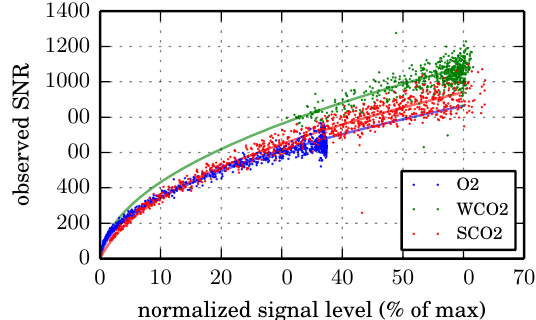
Figure 6. Empirical SNRs of each OCO-2 band derived from Fig. 6. Empirical signal-to-noise ratios of each OCO-2 band de- the standard deviation of spectral residuals from 2000 separate rived from the standard deviation of spectral residuals from 2000 fits. Solid transparent lines represent the expected OCO-2 SNR separate fits. Solid transparent lines represent the expected OCO-2 for a typical detector pixel, which agrees well with the observed SNR for a typical detector pixel, which agrees well with the ob- SNR. For each band (O2A, WCO2, SCO2), the maximum ob- served SNR. For each band (O2A, WCO2, SCO2), the max ob- servable signal is defined as 7 . 0 × 10 20 , 2 . 45 × 10 20 and 1 . 25 × servable signal is defined as 7 . 0 10 20 , 2 . 45 10 20 and 1 . 25 10 20 · · · 10 20 photonss − 1 m − 2 sr − 1 µm − 1 , respectively, where it is taken photons s − 1 m − 2 sr − 1 µ m − 1 , respectively, where it is taken into into account that OCO-2 will only measure one polarization direc- account that OCO-2 will only measure one polarization direction tion (i.e., the maximum signal level in terms of full intensity would (i.e. the maximum signal level in terms of full intensity would be be twice as high as provided twice as high as provided here).